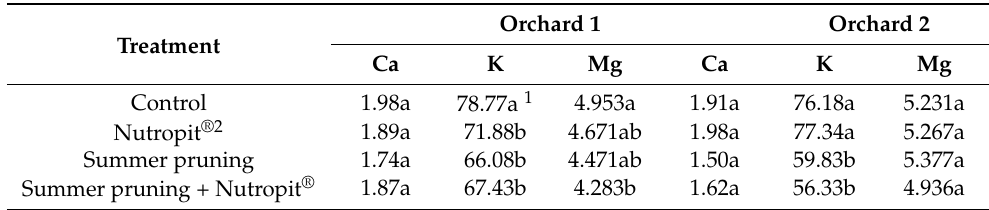
Table 1. Effect of sustainable techniques on mineral concentration (mg/100 g FW) in apple fruit cv. ‘Reinette du Canada’.